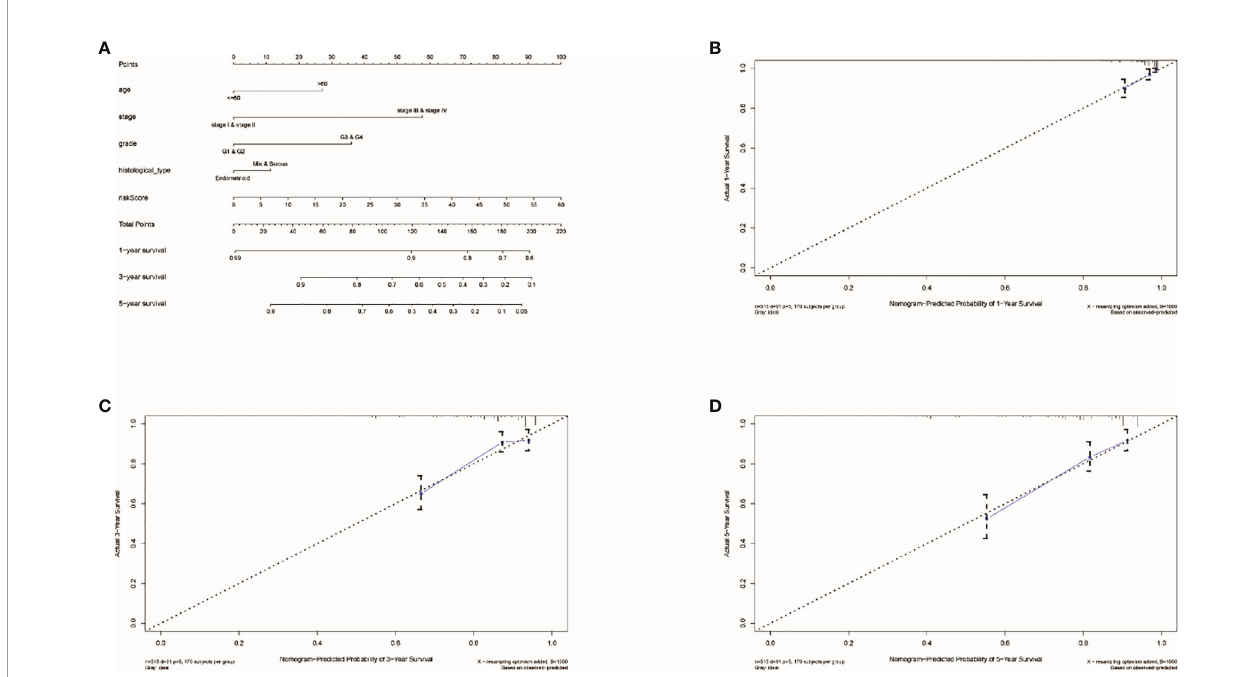
FIGURE 5 | Results of nomogram prediction. (A) An immune nomogram for predicting the survival rates of UCEC patients in 1, 3, and 5 years. The calibration curve of the constructed nomogram of 1- (B) , 3- (C) , and 5-year (D)